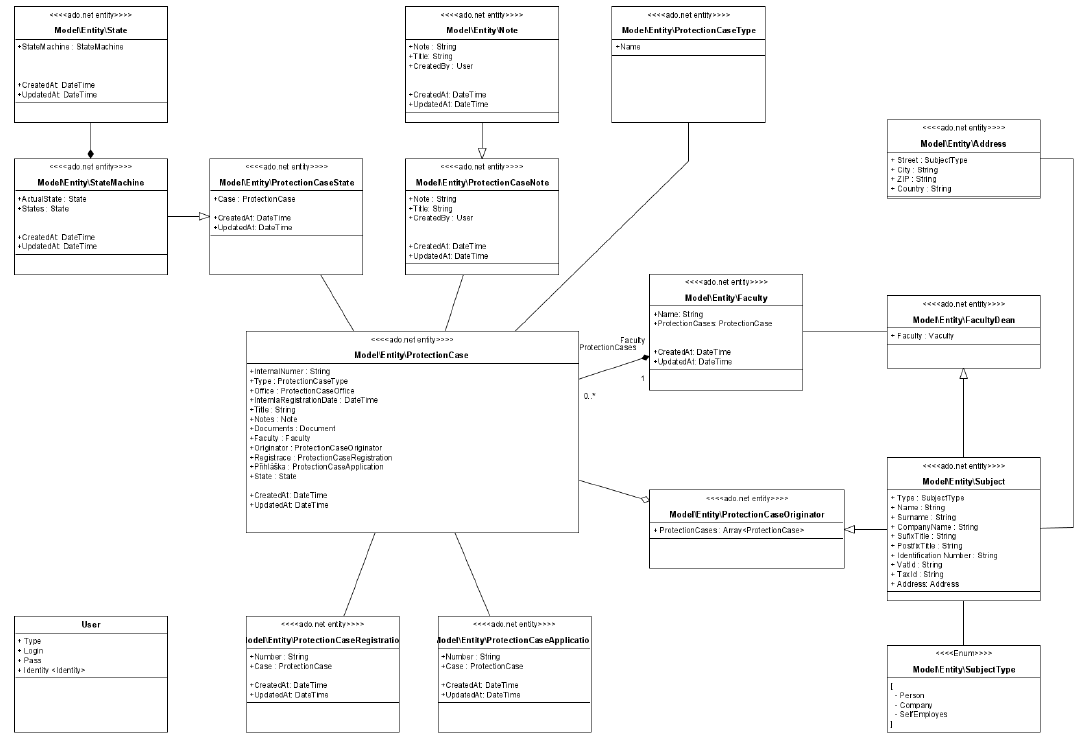
Figure 1. Class diagram of relation and inheritances between model entities. The “protectionCase” is the central entity which represents the intellectual property right (IPR) case itself. The states and state machine implement the business logic of the protection case.